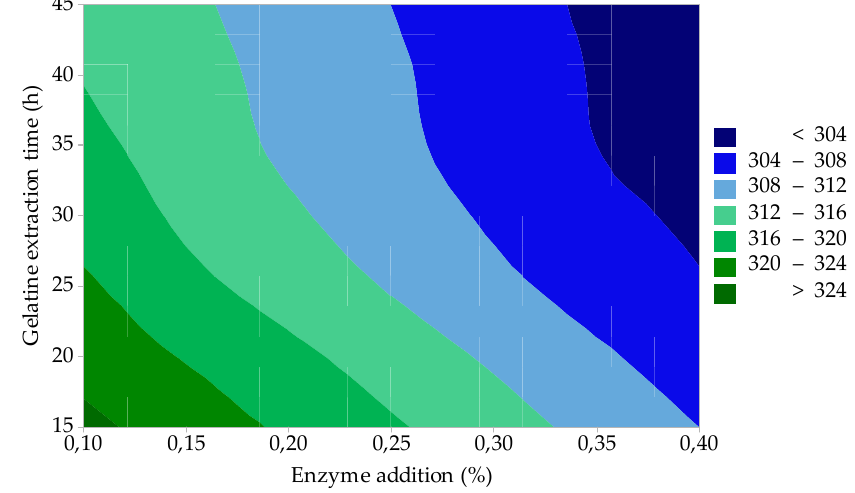
Figure 4. E ff ect of enzyme addition and gelatine extraction time on gelatine gel strength Figure 4. Effect of enzyme addition and gelatine extraction time on gelatine gel strength (process (process optimization).